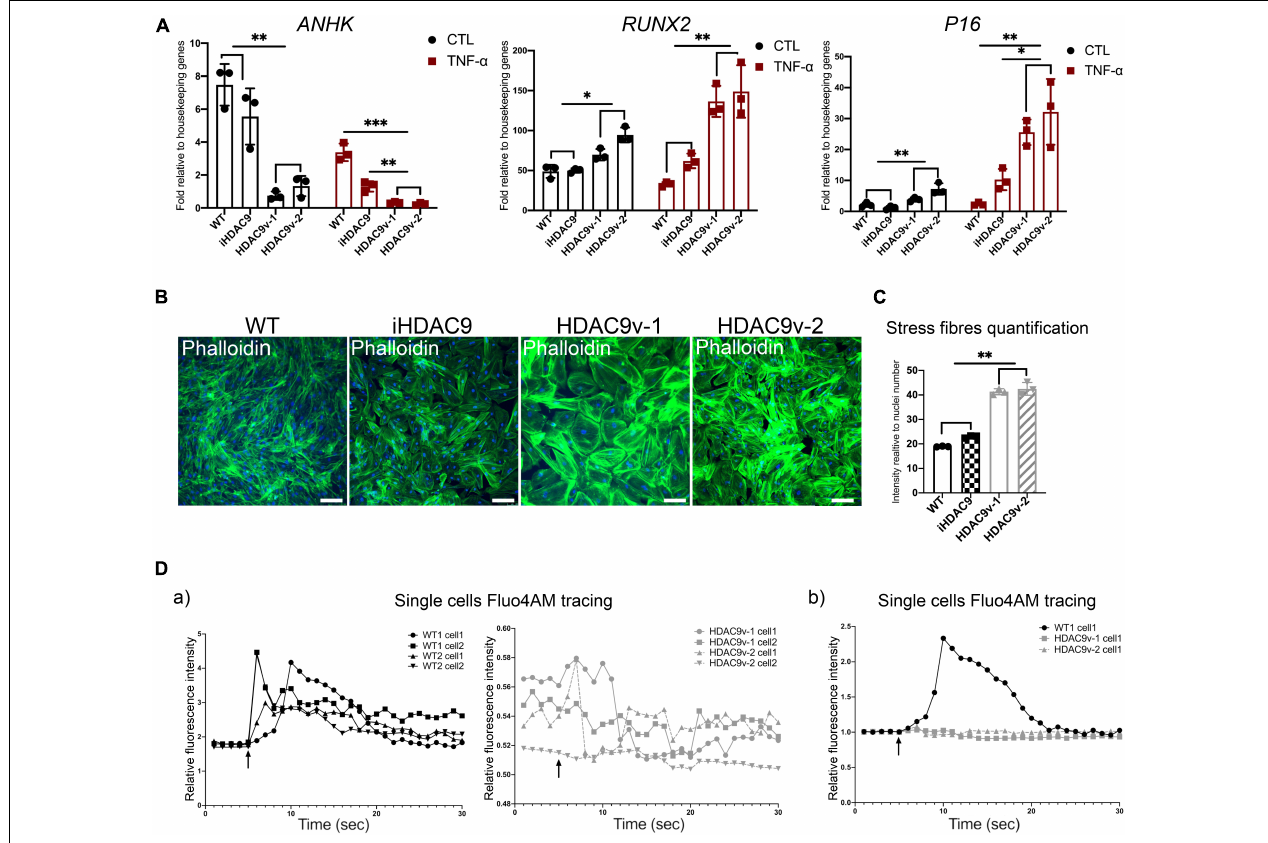
FIGURE 6 | Histone deacetylase 9 risk variant SMC show a senescence-like phenotype. (A) RT-qPCR analysis of ANKH and RUNX2 and P16 genes in WT ( n = 3), iHDAC9, HDAC9v-1, and HDAC9v-2 CTL and upon TNF- α stimulation. (B) Phalloidin staining for WT, iHDAC9, HDAC9v-1 and HDAC9v-2 SMC and (C) quantification. (D) Single-cell fluorescence tracing of WT1, WT2, HDAC9v-1 and HDAC9v-2 SMC before and after carbachol stimulation (5 s), relative to basal level and total Fluo-4AM loading (a) and compared to WT (b). Nuclei were stained with DAPI. Scale bar = 100 µ m. The result is representative of three independent experiments (means ± SD). ∗ P < 0.05; ∗∗ P < 0.01. Statistical analysis was performed by 2-way (A) and 1-way (C) ANOVA with Tukey’s multiple comparison